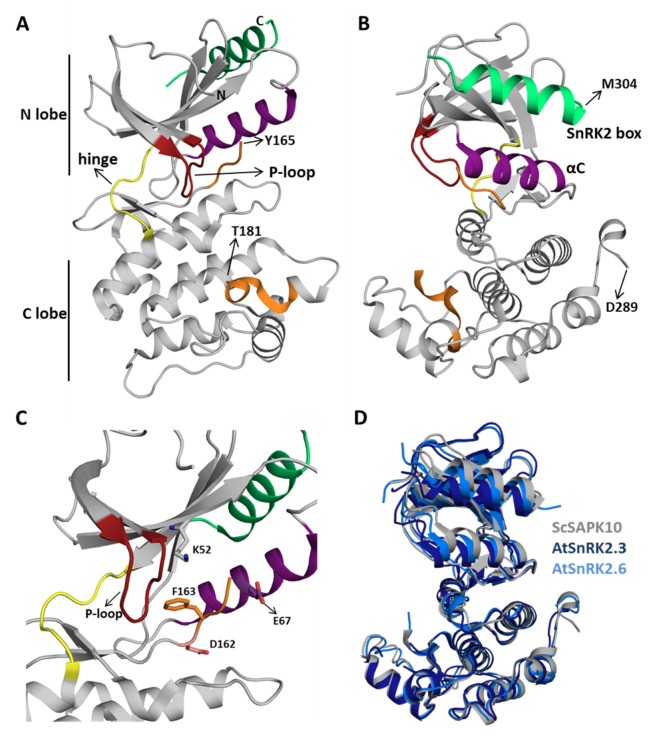
Sugarcane SAPK10 has a canonical kinase fold and a conserved SnRK2 regulatory domain. (A and B) Cartoon representation of the ScSAPK10 structure. Highlighted regions represent some of the key regions for kinase activity and/or regulation: ATP binding loop (red), αC (purple), activation loop (orange), and SnRK2 box (green). The hinge region that connects the N- and C-terminal lobes of the kinase domain is colored in yellow. Residues Y165-T181 and D289-M304 were not resolved in the electron density. (C) Cartoon representation of ScSAPK10 ATP-binding site. The ATP-binding loop (red), the activation loop residues D162 (pink) and F163 (orange), as well as the residues K52 (grey) and E67 (purple) related to phosphate transfer, are highlighted. (D) Structural alignment of ScSAPK10 (gray), Arabidopsis SnRK2.3 (PDB ID: 3UC3—dark blue), and SnRK2.6 (PDB ID: 3ZUT—light blue).